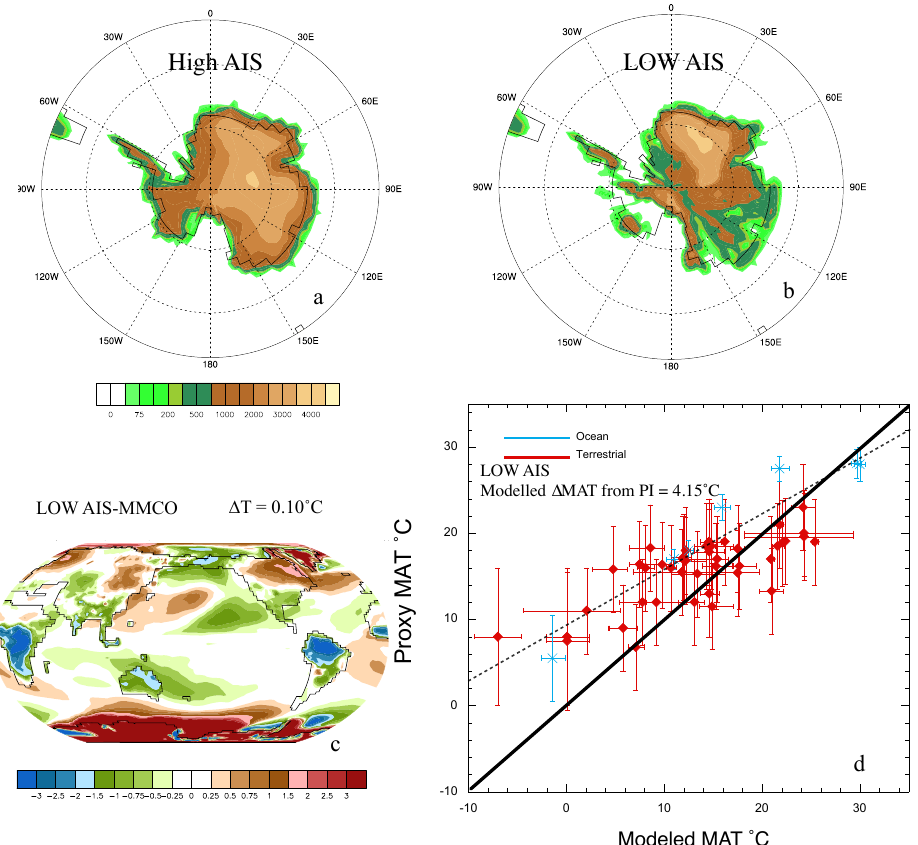
Fig. 4. (a) High AIS topography (meters) used in Herold et al. (2011), (b) LOW AIS topography based on offline ice-sheet modeling (David Pollard, personal communications, 12 April 2012), (c) modeled temperature anomaly ( ◦ C) between the LOW AIS simulation and the MMCO simulation with the high AIS. (d) Pointwise MAT comparison between the LOW AIS simulation and proxy records (Tables S1, S2). The best fit line (black dashed) is weighted to include error uncertainty and is fitted across all points and the y intercept and slope are reported in Table 1.